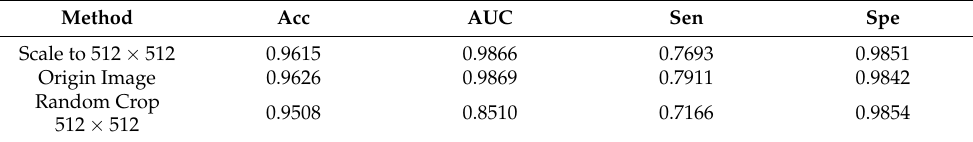
Table 7. The performance of different settings in the DRIVE dataset.